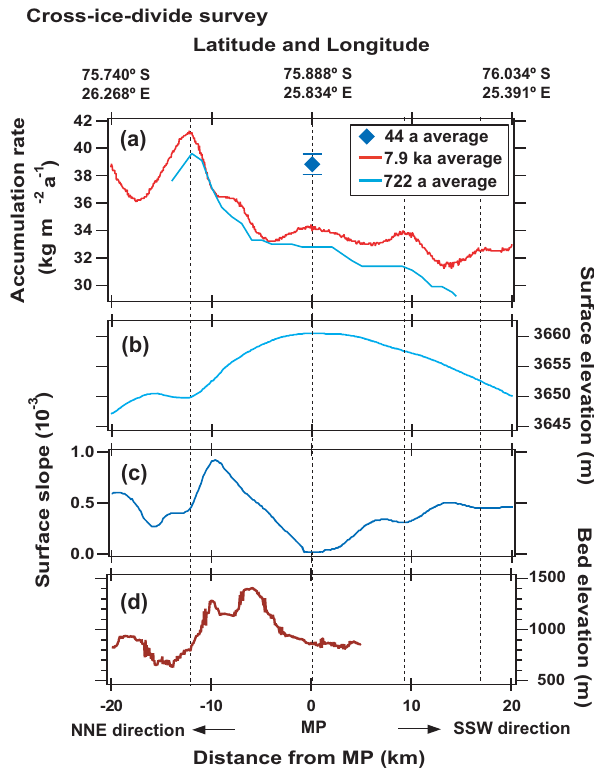
Fig. 8. Values of accumulation rate are shown versus site elevation. Panel (a) shows data selected from Figs. 3a and 4a. The group in the upper left is data from sites along the main ice divide between Dome Fuji and A28. The group at the lower left side is data from sites along the south route between Dome Fuji and A38. The group on the right side is data from sites along the ice divide branch DML- A between A28 and EPICA DML. Panel (b) shows surface slope.